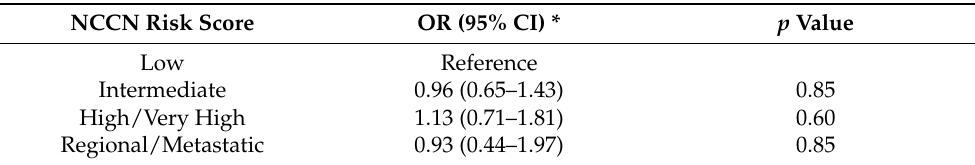
Table 2. Association of high urinary PGE-M with national comprehensive cancer network risk (NCCN) score for metastatic prostate